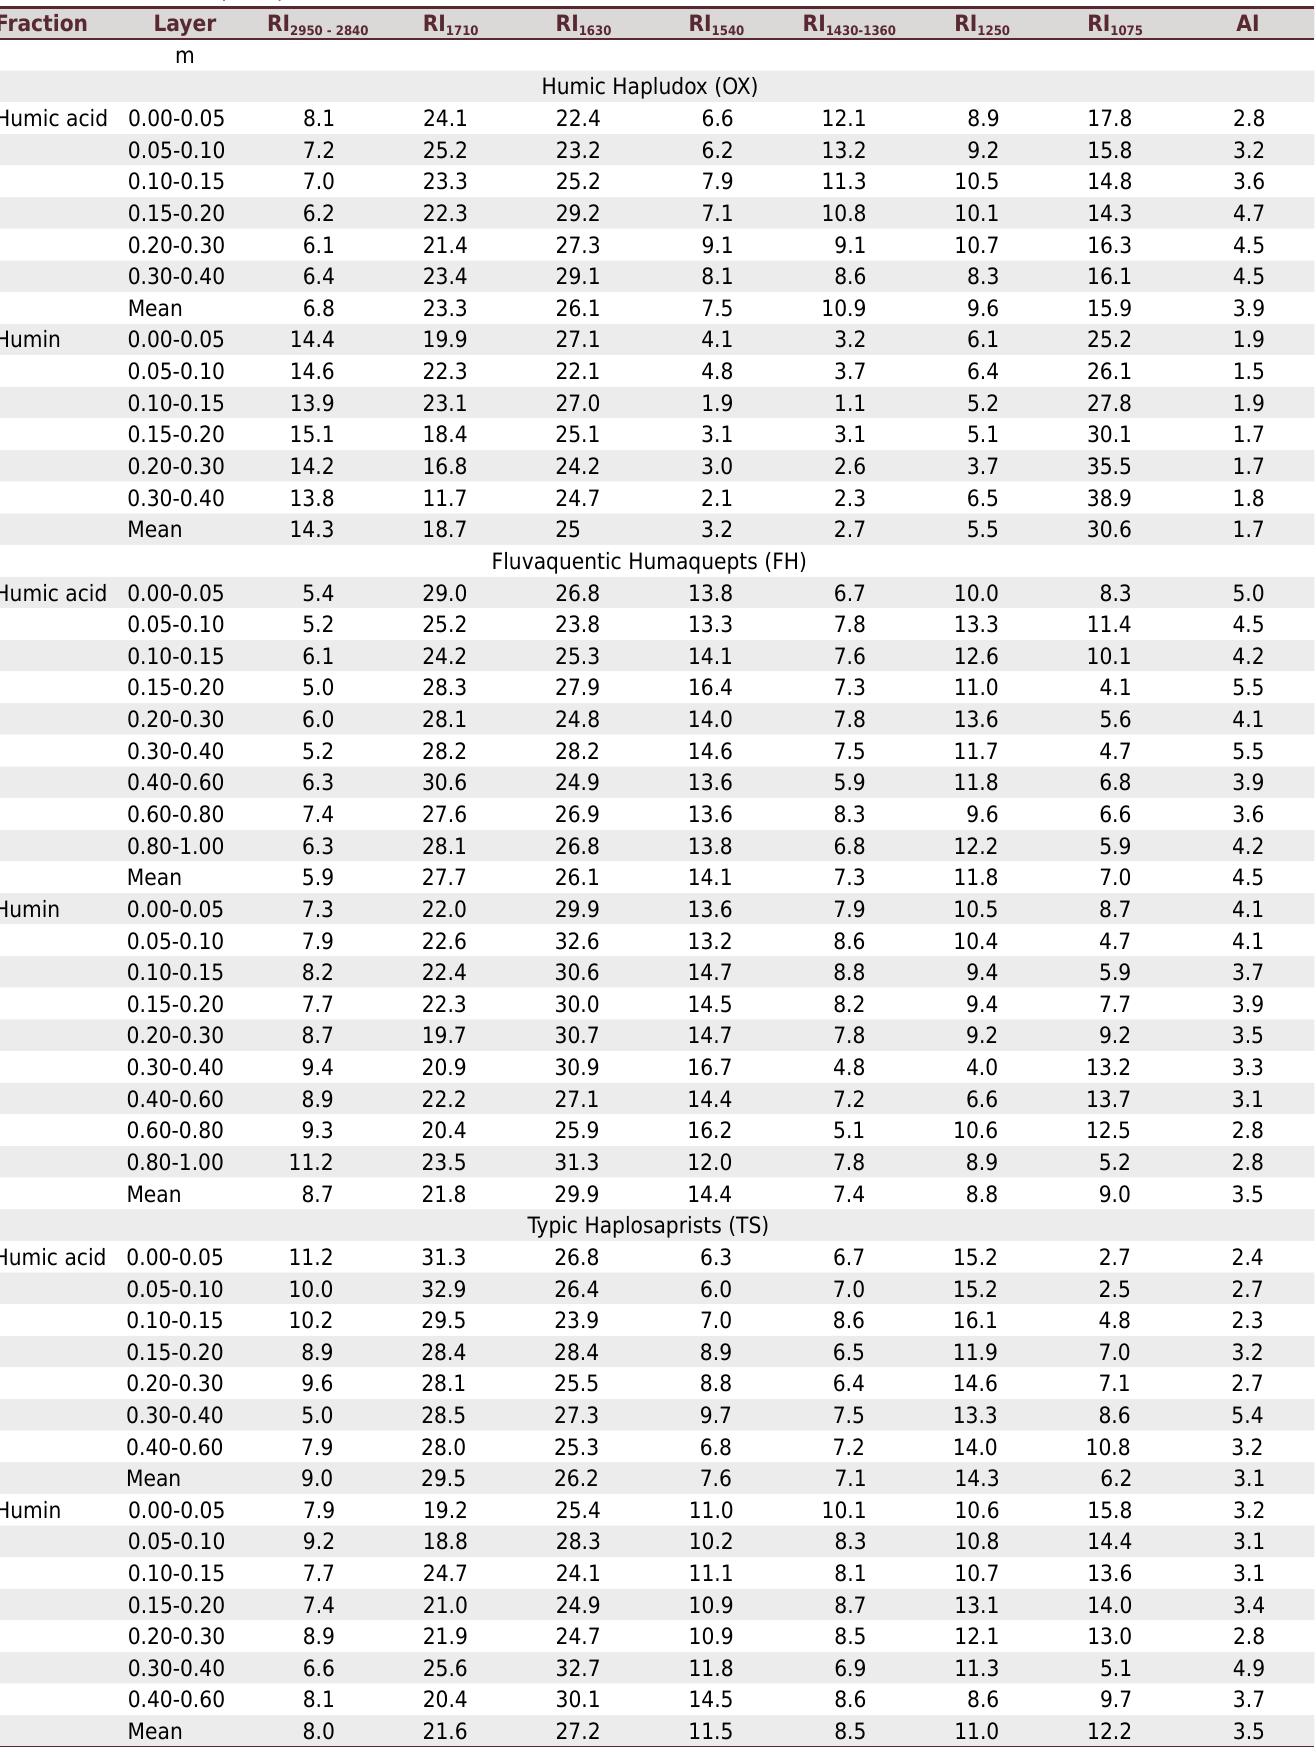
Table 3. Fourier transform infrared spectroscopy spectral relative intensities (RI) and aromatic index (AI) of soil organic matter fractions of soils in a toposequence under Araucaria moist forest in southern Brazil Fraction Layer RI 2950 - 2840 RI 1710 m Humic Hapludox (OX) Humic acid 0.00-0.05